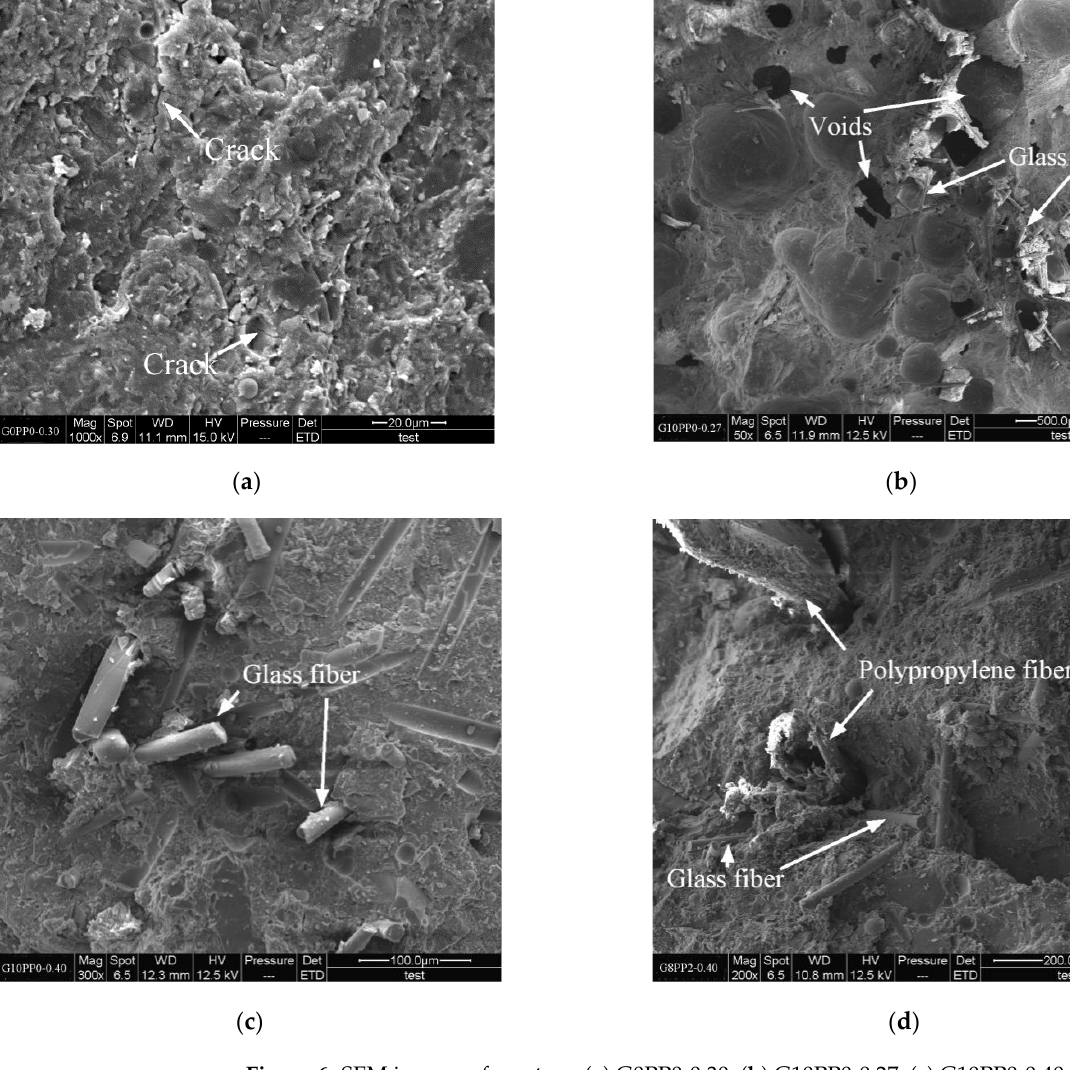
Figure 6. SEM images of mortars: ( a ) G0PP0-0.30; ( b ) G10PP0-0.27; ( c ) G10PP0-0.40; ( d ) G8PP2- 0.40.